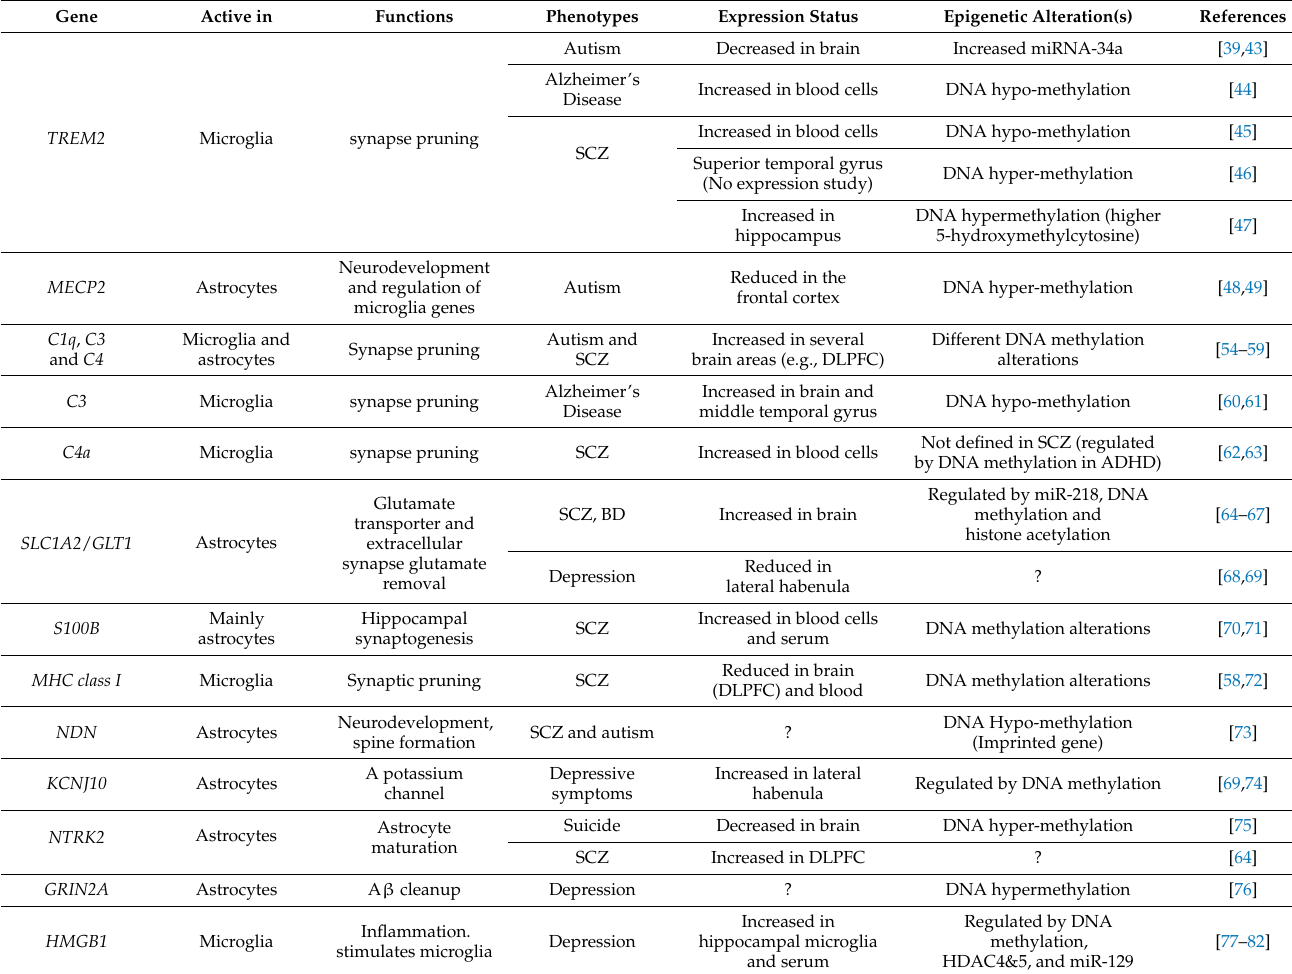
Table 1. Genes linked to non-neuronal brain cell function and supporting evidence indicating their epigenetic dysregulation in mental